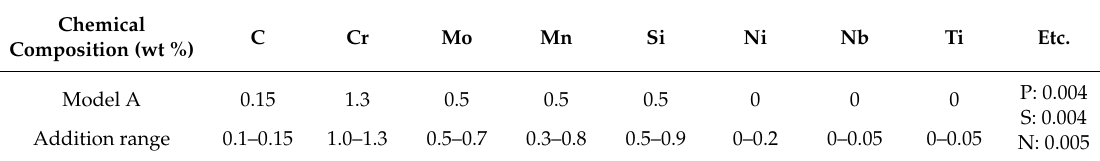
Table 1. Chemical composition of Fe-C-Cr-Mo-Mn-Si model alloy used to study the effect of elements by JMatPro-Thermo-Calc simulation.